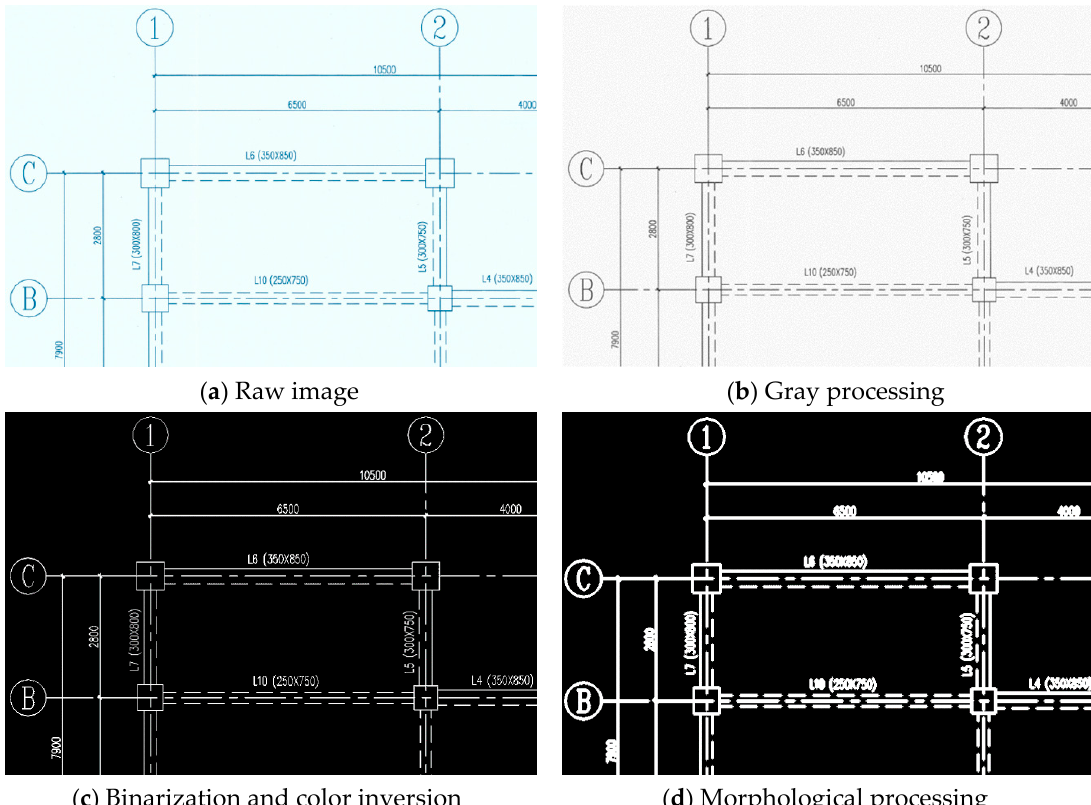
Figure 2. Image preprocessing results in different phases.